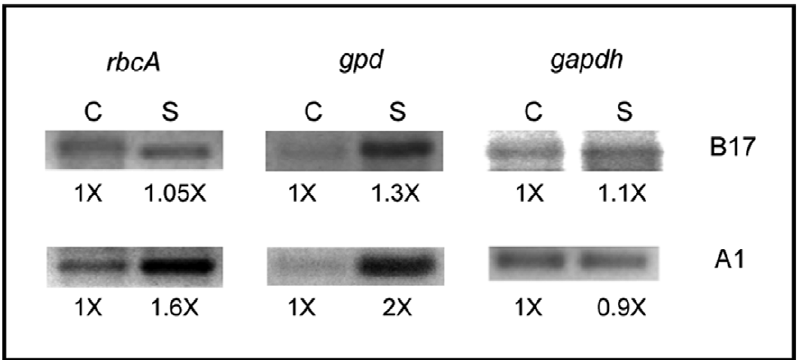
Figure 4. Expression of genes associated to carbon fixation (Rubisco, rbcA ) and synthesis of glycerol (glycerol 3-phosphate dehydrogenase, GPD ). RT-PCR from 1 m g RNA extracted from Symbiodinium type B17 (upper panel) or type A1 cultures (lower panel) exposed to control (left lanes) or osmotic stress conditions (right lanes) for 1 hr. The amplification products were separated in agarose gels photographed, scanned and quantified with the ImageJ program (Rasband, W.S., ImageJ, U. S. National Institutes of Health, Bethesda, Maryland, USA, http://imagej. nih.gov/ij/, 1997–2011). Color was inverted in the scans for clearer visualization. Numbers represent relative intensity of bands normalized to transcript levels for GAPDH (glyceraldehyde 3-phosphate dehydrogenase, see